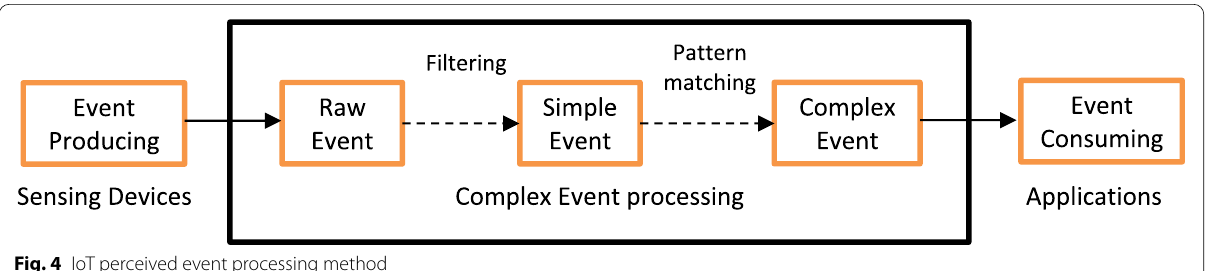
Fig. 4 IoT perceived event processing method